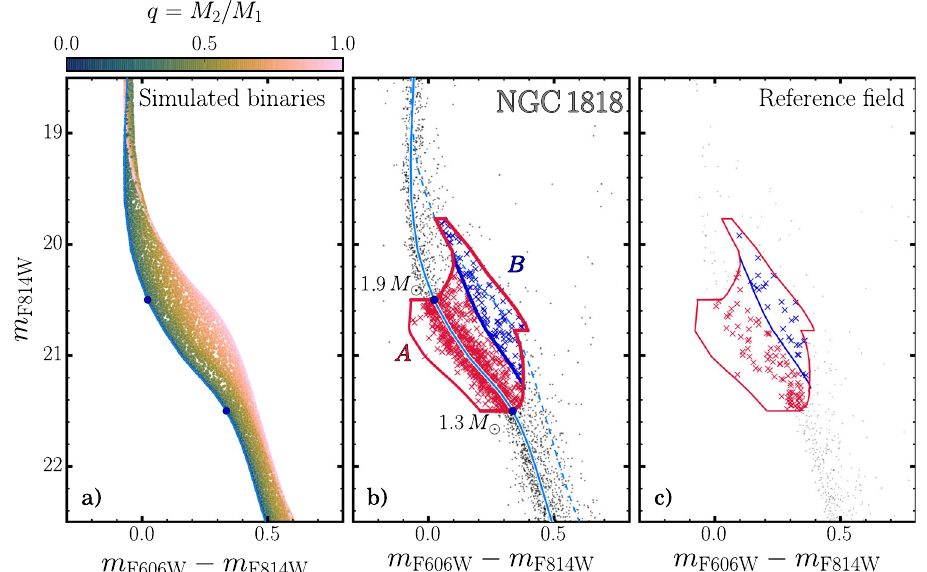
Fig. 5 | Binary fraction of NGC 1818. a CMD of a simulation of a population of 100,000 MS-MS binaries, with each binary system colour-coded according to its massratio q = M 2 / M 1 ,where M 2 isthemassofthesecondarystarand M 1 themassof the primary star, as shown in the top colourbar. b Unresolved binaries selection procedureforcluster- fi eldstars.Thelightbluesolidanddashedlinerepresentsthe MS fi ducial line and the MS-MS equal mass binaries fi ducial line, respectively. The